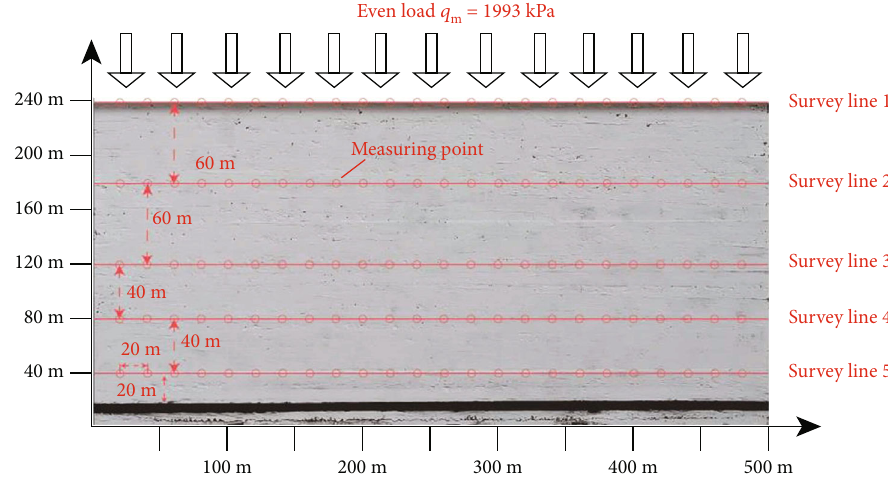
Figure 3: Physical similarity model of the working